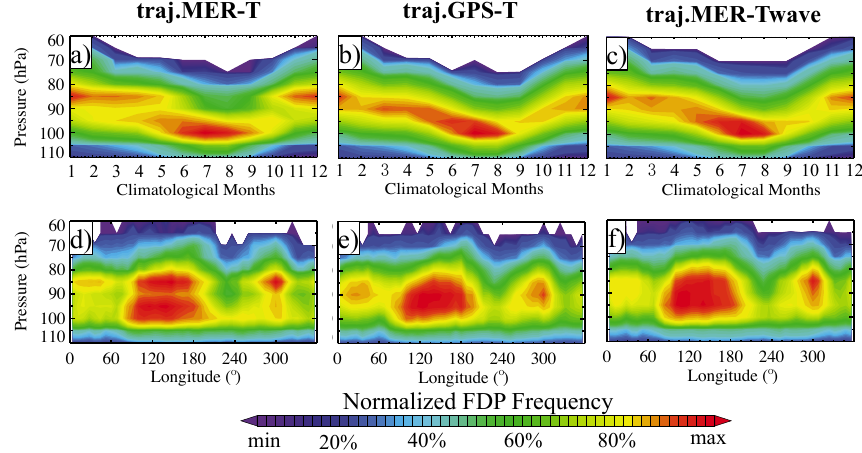
Figure 6. Vertical distributions of normalized FDP events in time-evolutional (a – c) views among trajectory simulations by using (a) MERRA temperature ( traj.MER-T ), (b) GPS RO temperature ( traj.GPS-T ), and (c) MERRA temperature adjusted by waves ( traj.MER-Twave ). The longitudinal variations of FDP are highlighted in (d – f) to emphasize the FDP discontinuity in traj.MER-T . All panels are plotted in their own range and color-coded at the same percentiles (i.e., 0, 20, 40, ... 100%) to compare the